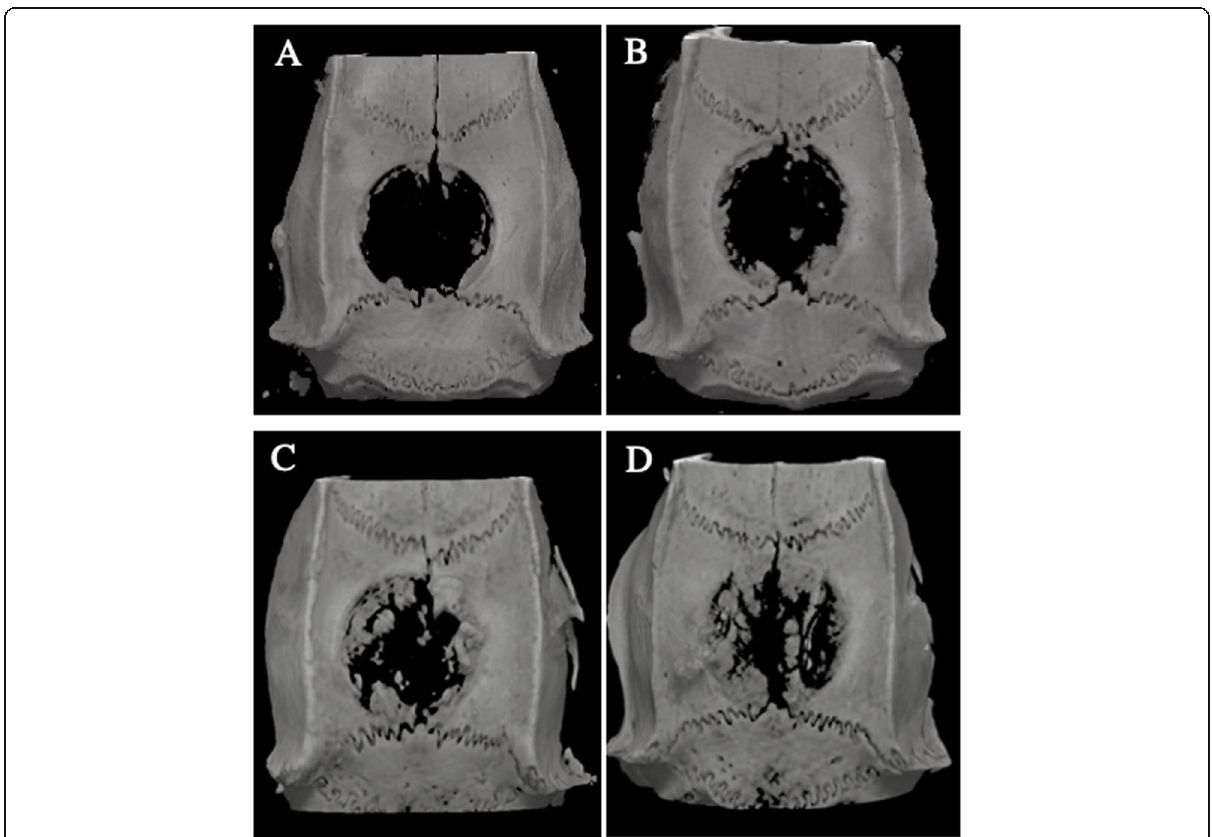
Fig. 2 Radiographic analysis was performed. a 3D images at 1 week in the control. b 3D images at 1 week in the test. c 3D images at 2 weeks in the control. d 3D images at 2 weeks in the